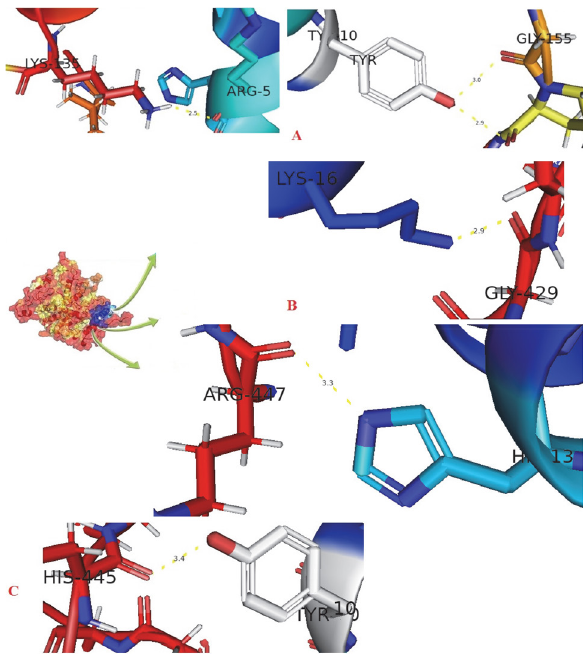
Figure 9. The FRODOCK2 model results of Aggregatin and Aβ 28 peptides. Binding modes of Aggregatin and Aβ42 in surface rep- resentations are shown. A.) Aggregatin(LYS135) interacts with the residue of ARG5, GLY155 with TYR10 of the Aβ 28. Aggregat- in(LYS429) interacts with LYS16, ARG447 with HIS13 of the Aβ 28. C.) Aggregatin(HIS445) interacts with TYR10 of the Aβ 28. In this binding mode, TYR10, HIS13, and ARG5 residues are common to both Aβ 28 and Aβ 42 in docking